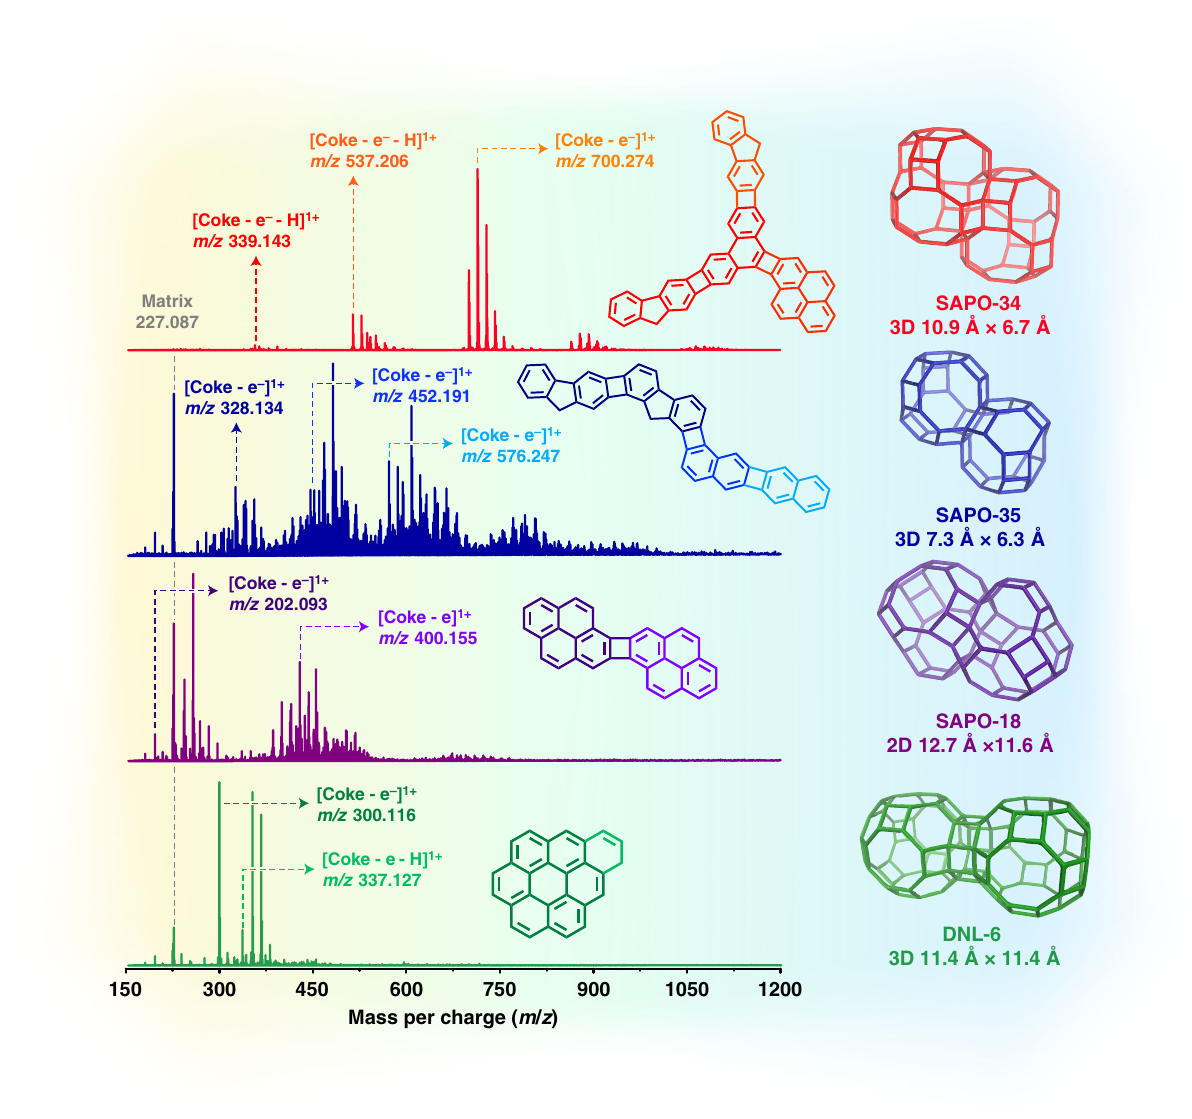
Fig. 6 Molecular structure analysis of PAHs in other cage-structured molecular sieves. MALDI FT-ICR mass spectra for extracts obtained from other cage-structured molecular sieves and the deduced possible molecular structure of PAHs. The indicated molecular structures are representative examples of possible